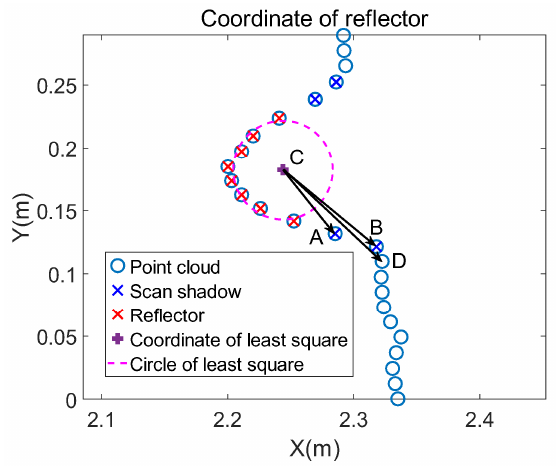
Figure 8. The blue points are scan shadows of the reflector. The reflector is placed in front of the wall. Therefore, a laser beam is divided into two beams. One radiates on the edge of the reflector and the other one radiates on the wall. This makes the final point cloud between the reflector and wall and affects modifying the coordinate.